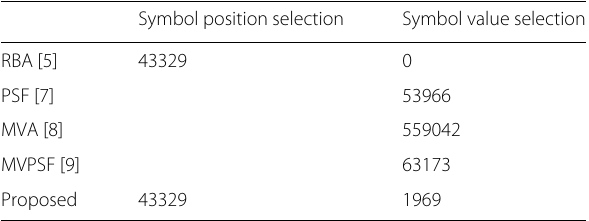
Table 4 Number of real operations for the symbol flipping algorithm for 1023 × 781, GF(16) LDPC